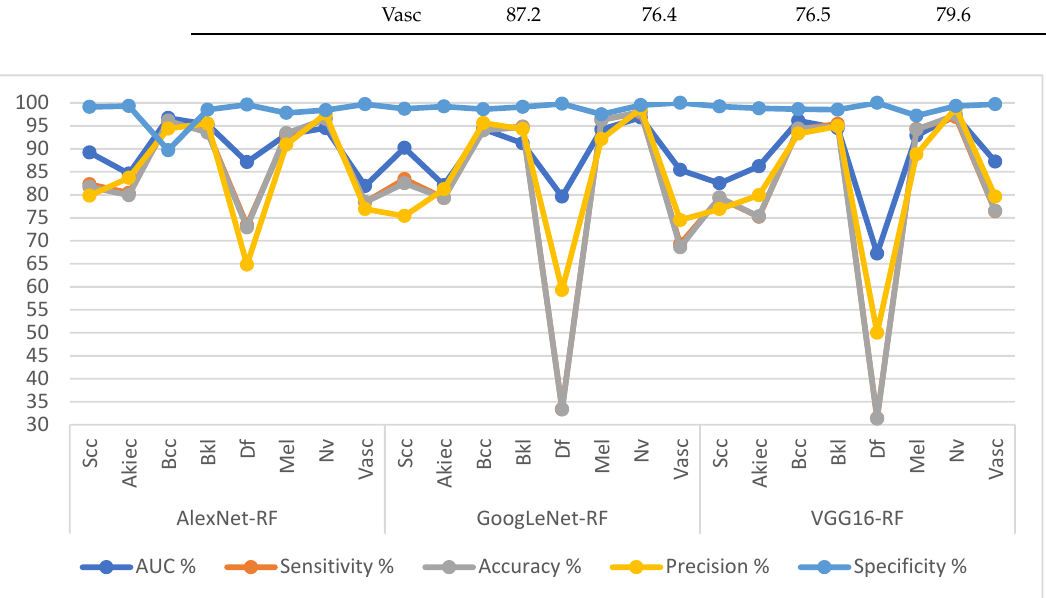
Figure 10. Display Performance results of CNN-RF hybrid models based on ROI using the GAC method for early diagnosis and discrimination of skin cancer and other skin lesions.